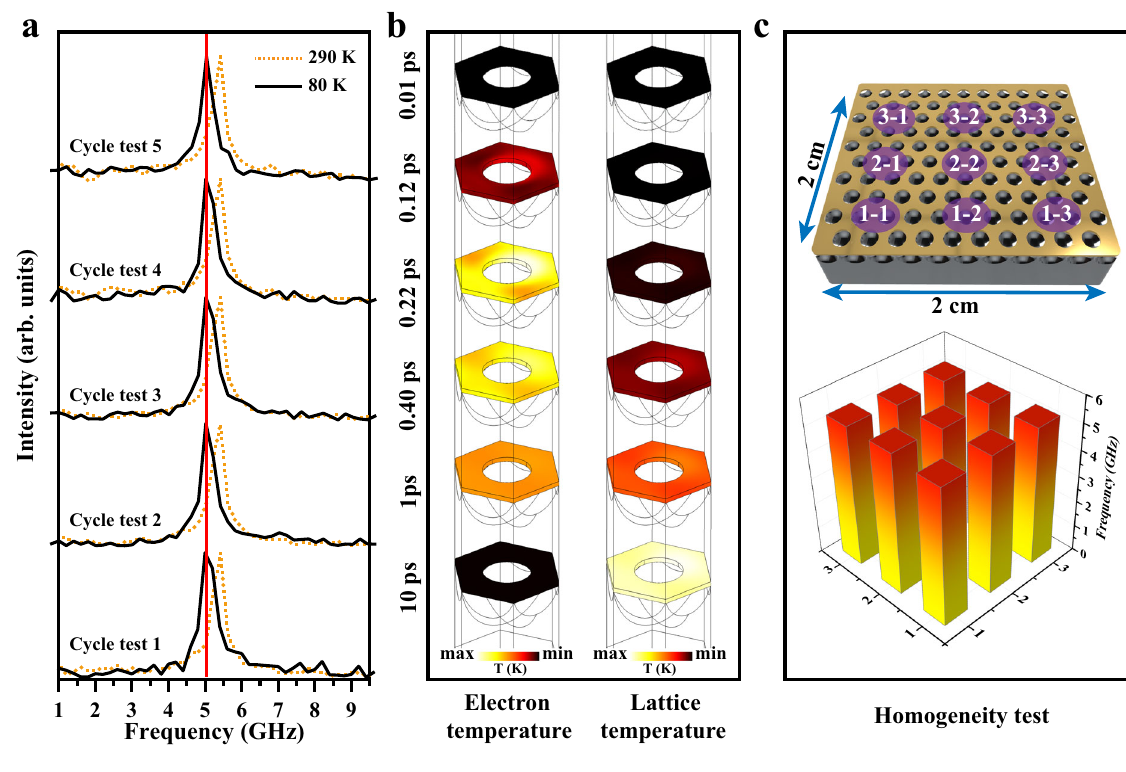
Fig.5|Stabilitymeasurements.a OscillationFFTspectrumoftheTSNOMSunder 5 temperature change cycles. b Simulated thermal distribution of electron and latticetemperaturesontheTSNOMS. c Illustrationoftheaerialpump-probescanof